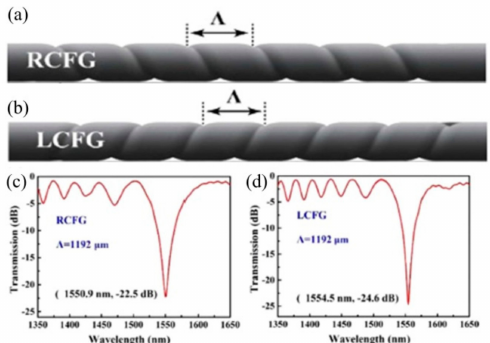
Figure 14. Diagram of periodic helical structure in the ( a ) right-handed and ( b ) left-handed HLPFG in four-mode fiber (FMF); Transmission spectra of ( c ) the right-handed and ( d ) left-handed HLPFG